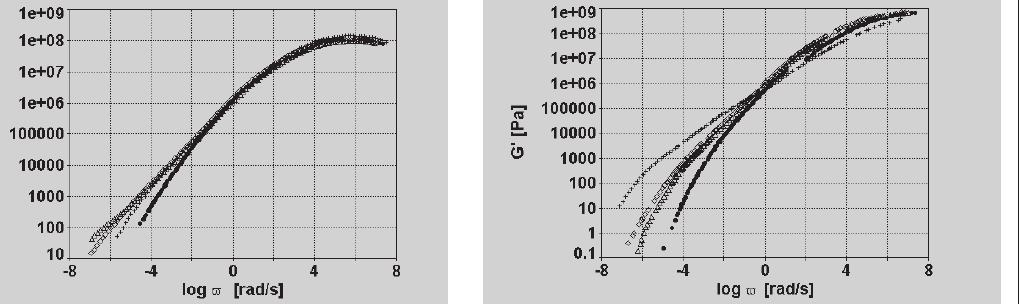
Figure 4 (left): Loss modulus (T r = 0°C: • Base, + 4% EVA, (cid:3)(cid:3) 4% SBS l, ◊ 4%SBSr). Figure 5: Storage modulus (T r = 0°C: • Base, + 8% SBSr, (cid:3)(cid:3) 2% SBSr, ◊ 2%